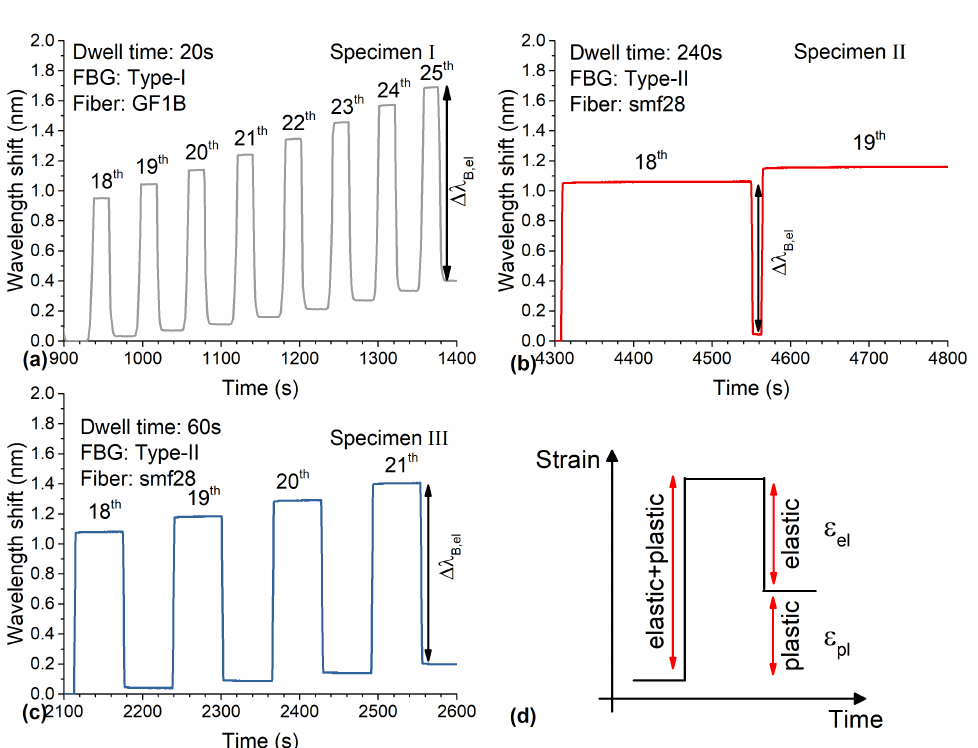
Figure 7. Wavelength shift of all FBGs with dwell times ( a ) 20s, ( b ) 240s, ( c ) 60s after the 18th cycle, and a schematic drawing of a loading state of one cycle as a function of time. The wavelength shift of all FBGs showed an elastic and plastic behavior under force and a permanent plastic wavelength shift after the force was released. ( d ) A similar pattern was observed with the extensometer with elastic and plastic components of the measured strain (schematic